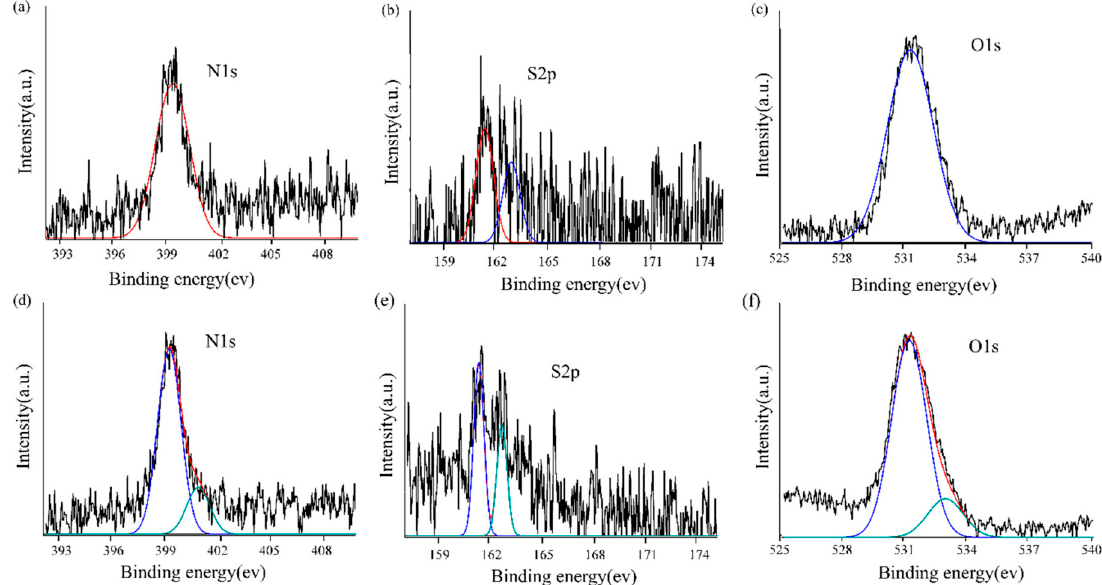
Figure 3. The XPS spectra of Au NPs/AET and Au NPs/T: ( a ) N1s spectrum of the Au NPs/AET; ( b ) S2p spectrum of Au NPs/AET; ( c ) O1s spectrum of the Au NPs/AET; ( d ) N1s spectrum of the Au NPs/T; ( e ) S2p spectrum of Au NPs/T; ( f ) O1s spectrum of the Au NPs/T.